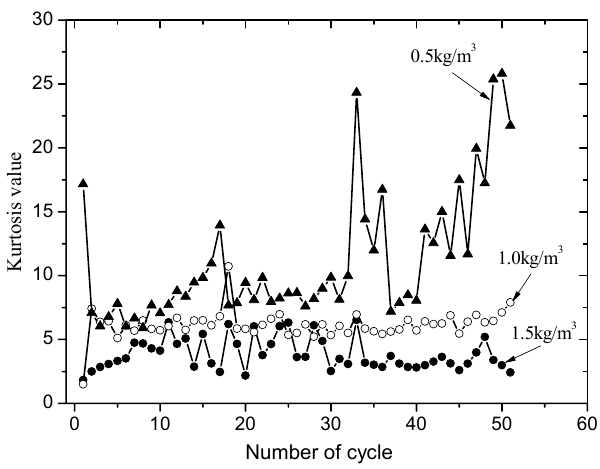
Figure 10. Kurtosis index for PVA fiber